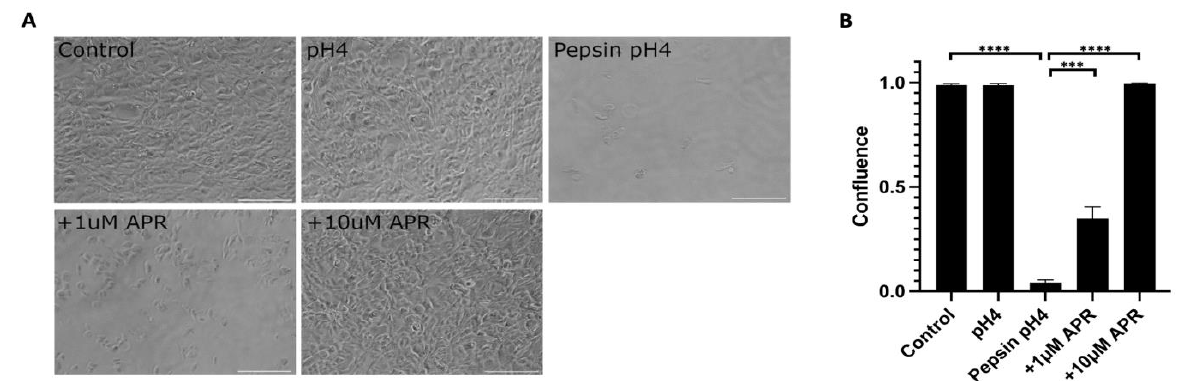
Figure 1. Amprenavir (10 µ M) rescued cell dissociation caused by 1 mg/mL pepsin at pH4. The partial rescue was achieved by 1 µM APR. Acid alone did not cause cell dissociation. ( A ) Repre- sentative images of experiments performed in triplicate. Scale bars equal 100 µ m. ( B ) Confluence as calculated using the FIJI plug-in PHANTAST (see Methods for details). Where significant, the following comparisons are shown: control vs. pH4, control vs. pepsin pH4, pepsin pH4 vs. +1 µ M APR, and pepsin pH4 vs. +10 µ M APR. *** = p < 0.001, **** = p < 0.0001.